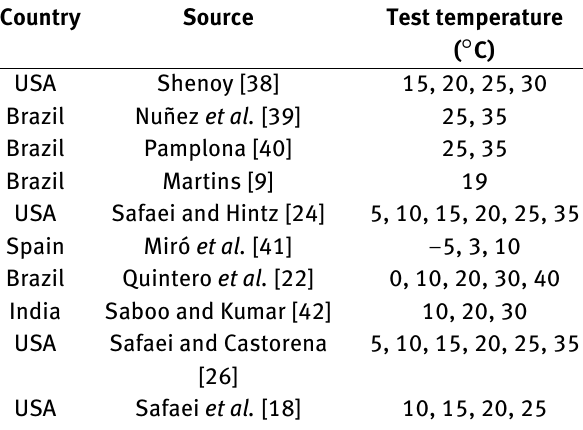
Table 2: Summary of test temperatures in previous studies of fa- tigue characterization